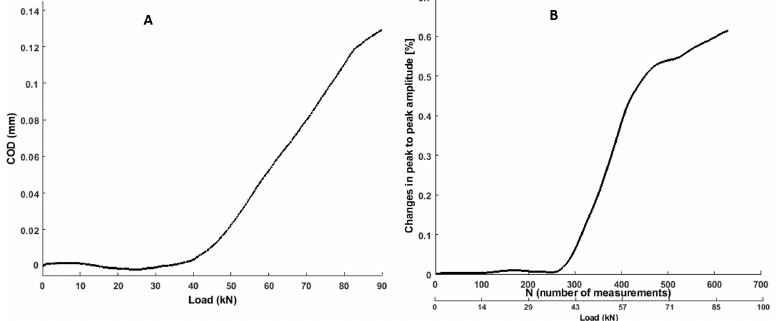
Figure 22. Load-COD ( A ) vs. load-changes in peak to peak amplitude ( B ) response of a RC benchmark